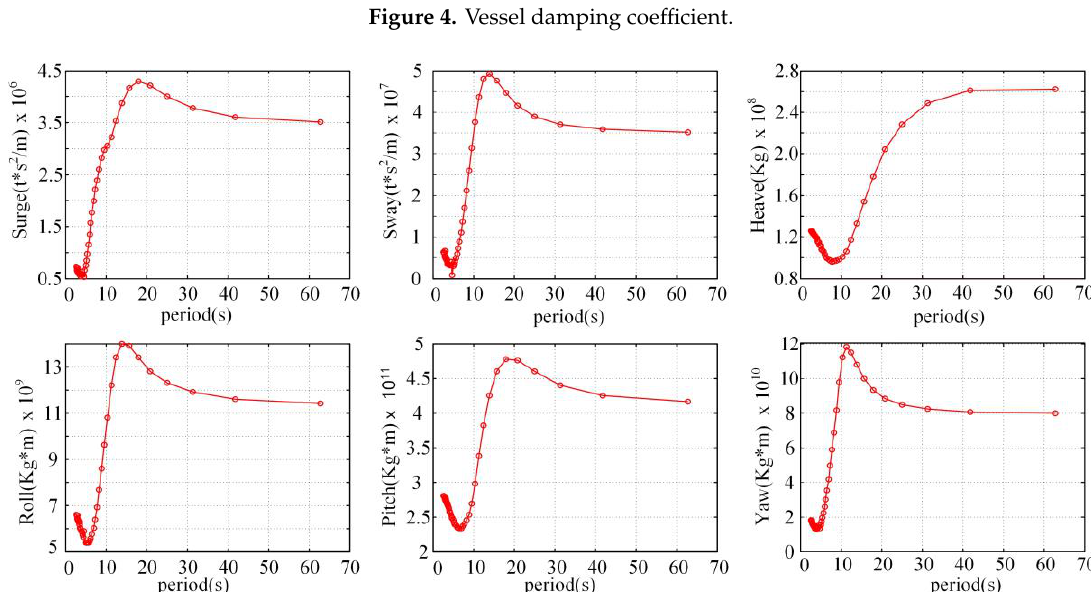
Figure 5. Vessel additional mass.